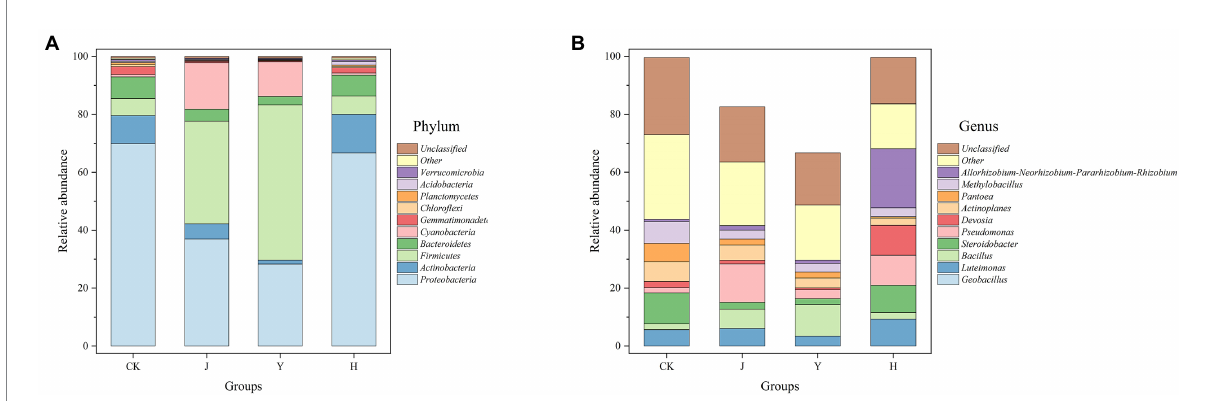
FIGURE 2 (A,B) Comparison of microbial populations at phylum and genus level in rhizosphere. CK represents soybean-potted rhizosphere soil inoculated with 50 mL saline solution. J, Y, and H represent soybean-potted rhizosphere soil inoculated with 50 mL Pseudomonas chlororaphis H1 inoculant,